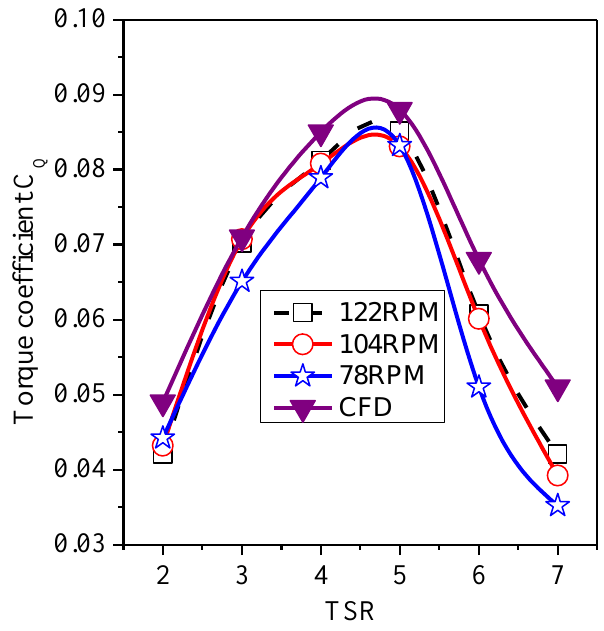
Figure 14. Torque coefficient C Q changes with TSR.